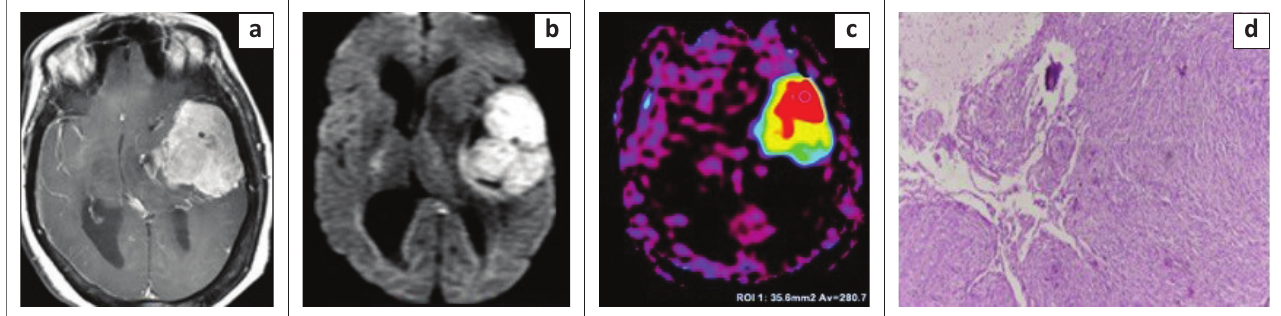
FIGURE 4: Images of a 62-year-old female who presented with dysphasia and difficulty in walking. A relatively well-defined lobulated extra-axial lesion was seen along the left temporal lobe. It revealed heterogeneous post-contrast enhancement (a). Brain-tumour interface was indistinct at a few sites. The lesion demonstrated diffusion restriction on axial diffusion-weighted imaging - apparent diffusion coefficient (ADC) not included (b) and a high cerebral blood flow value on arterial spin labelling (c). After surgery, histopathological photomicrograph (d) revealed tumour comprised of syncytia of epithelial cells with brain invasion (Hematoxylin and eosin staining, ×10) confirming the diagnosis of atypical TABLE 1: Typical versus atypical meningiomas. TABLE 3: Comparison between different subtypes of typical meningiomas. Parameters